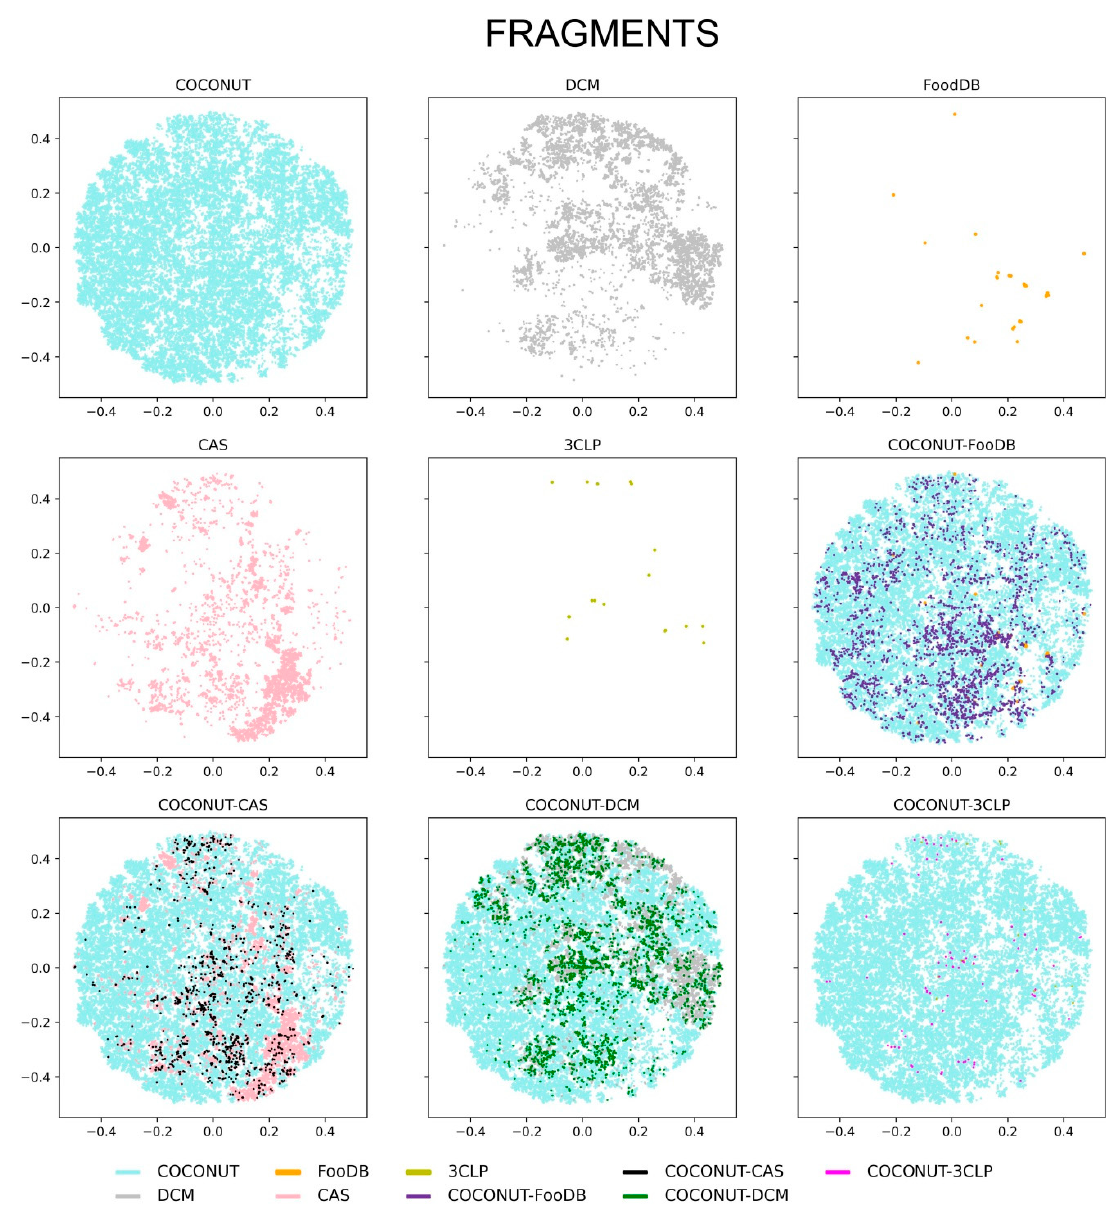
Figure 9. Visualization of the chemical space of fragments generated with Tree Maps. Datasets are represented with colors: COCONUT (cyan), DCM (gray), FooDB (orange), CAS (pink), and inhibitors of the main protease of SARS-CoV-2, 3CLP, (olive). Overlapping fragments in COCONUT–FooDB (purple), COCONUT–CAS (black), COCONUT–DCM (green), and COCONUT–3CLP (magenta) are indicated.